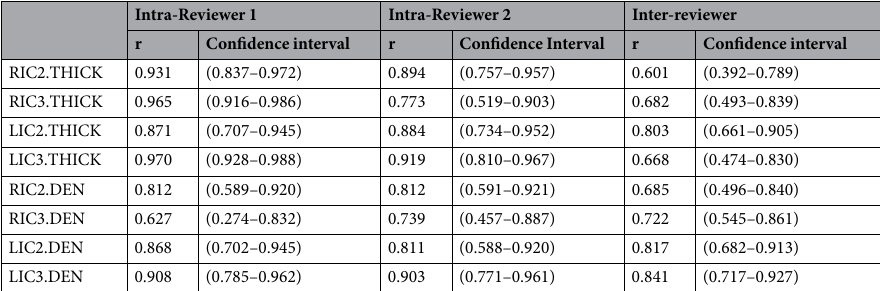
Table 3. Intraclass correlation – intra-observer variation. Intra-reviewer 1: ICC of reviewer 1 over two measurements. Intra-reviewer 2: ICC of reviewer 2 over two measurements. Inter-reviewer: ICC of all measurements for both reviewers by site. RIC2/3.THICK – 2 nd /3rd right intercostal thickness measurements. LIC2/3.THICK – 2 nd /3 rd left intercostal thickness measurements. RIC2/3.DEN – 2 nd /3 rd right